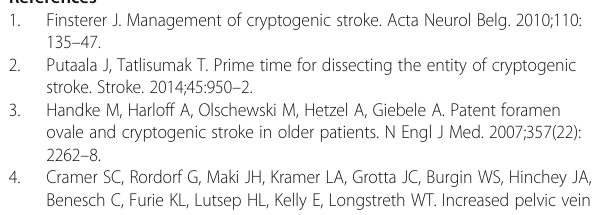
Table 2 Association between right to left shunting through trans-esophageal echo and trans-cranial duplex Right to left shunting through trans-esophageal